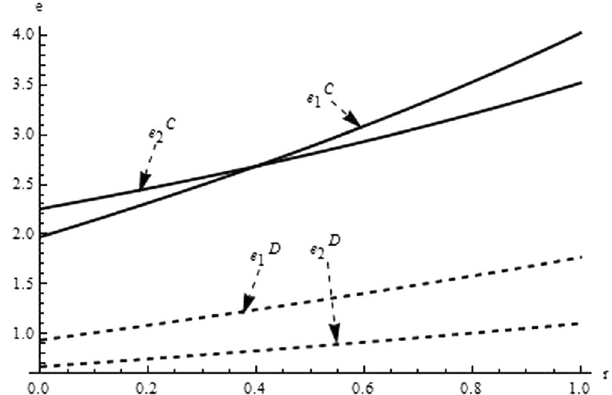
Figure 5. The impact of customers’ environmental awareness on carbon emission